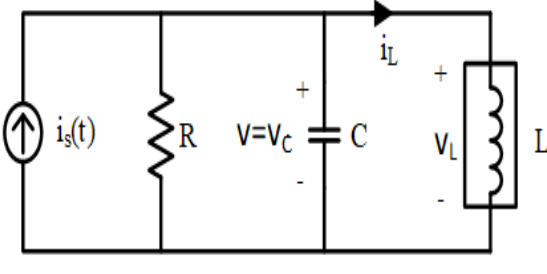
Figure 2. The motions of system (4).